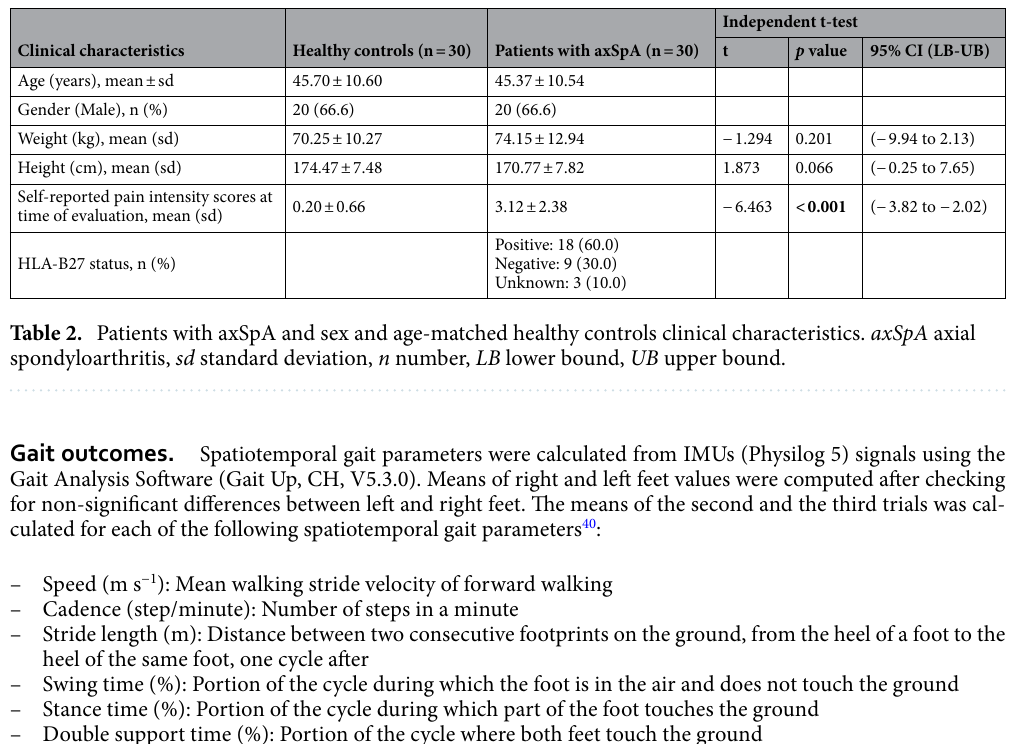
Clinical characteristics Healthy controls (n = 30) Patients with axSpA (n =